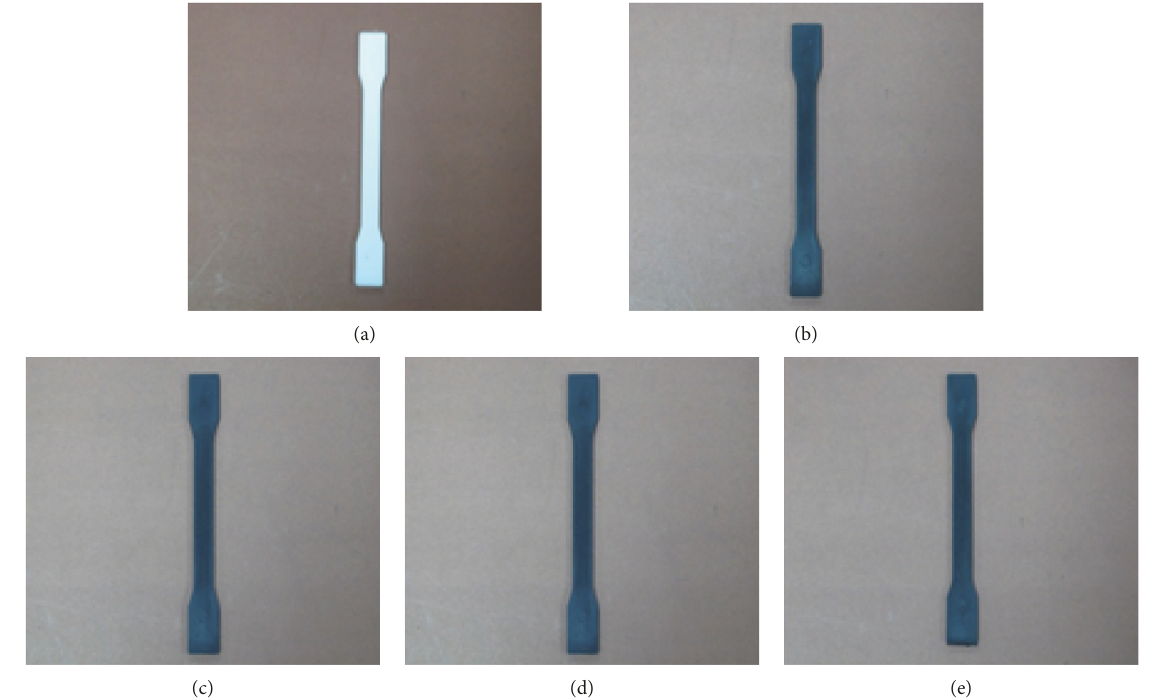
Figure 2: Photographic images showing physical appearance of (a) pristine PBS, (b) 3CB-PBS, (c) 5CB-PBS, (d) 10CB-PBS, and (e) 15CB- PBS composite materials after proceeded by an injection molding method.